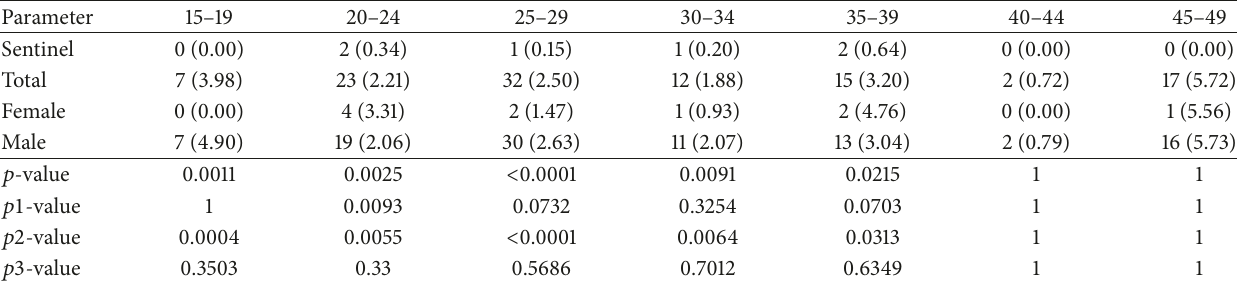
Table 6: Distribution of five-year burden of Syphilis infection by age